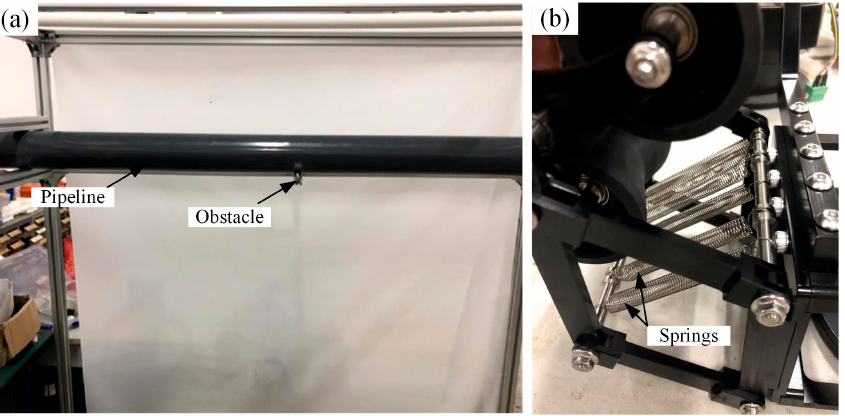
Figure 14. Experiment platform and tension spring installation: ( a ) Experiment platform; ( b ) Spring installation.